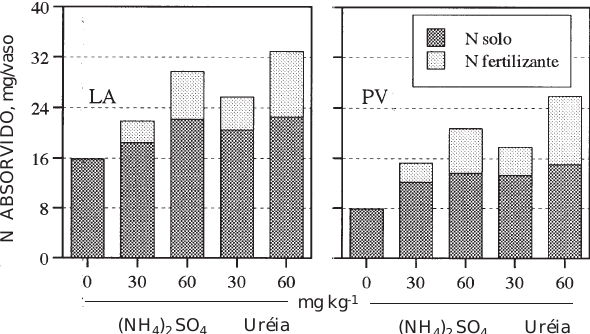
Figura 3. Distribuição de N proveniente do solo e do fertilizante na parte aérea do "rye-grass", em dois solos da Amazônia